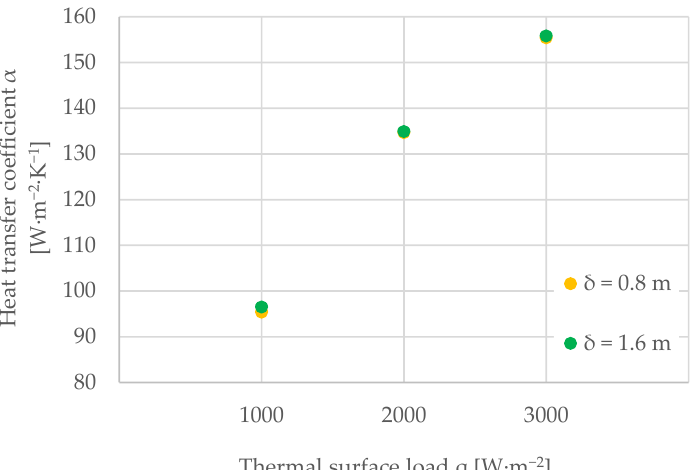
Figure 9. The heat transfer coefficient α depending on the heat load of the cooled surface q for different lengths of the heating element δ for mineral oil.